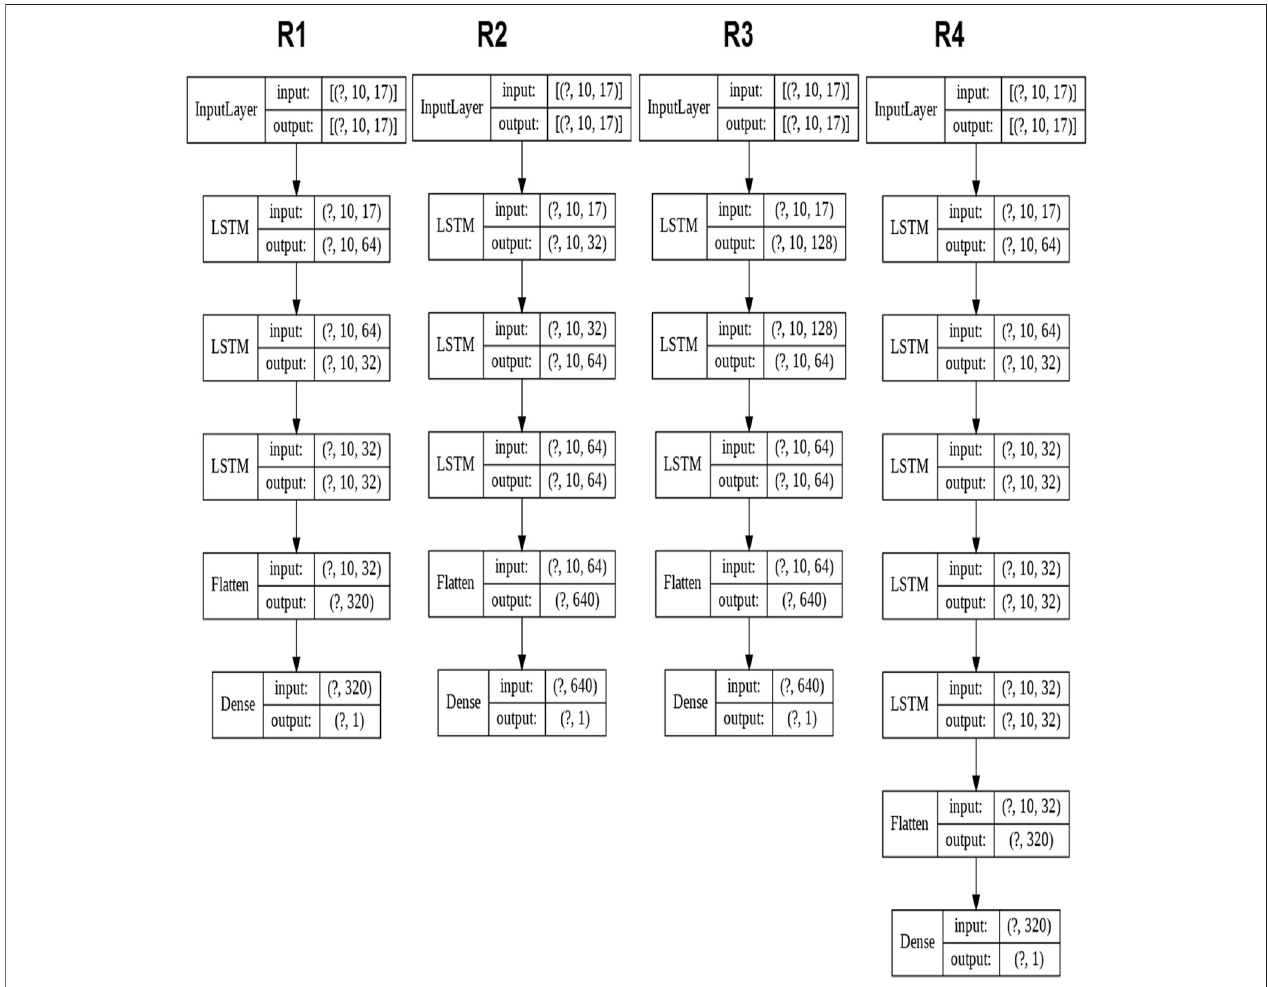
FIGURE 4 | Architectures of recurrent neural